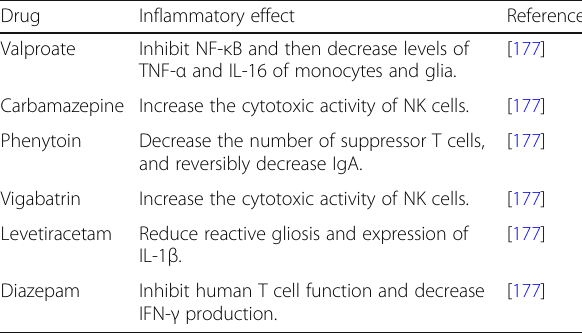
Table 2 Potential anti-inflammatory effects of anti-epileptic drugs Inflammatory